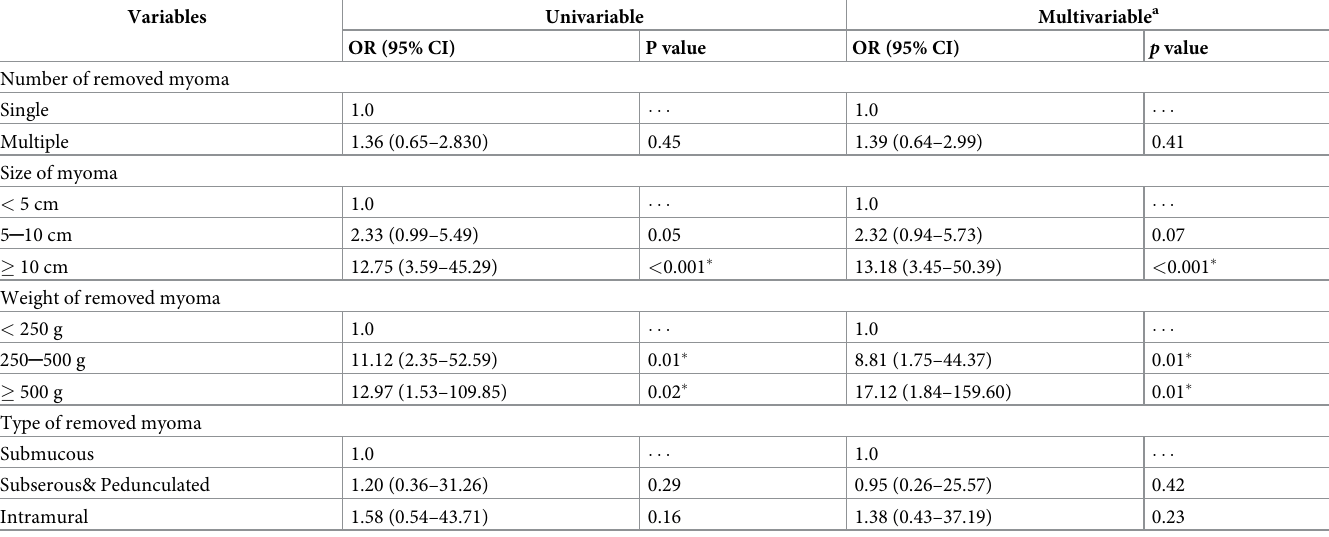
Table 8. Multivariate logistic regression model showing the unadjusted and adjusted odds ratios of association between various factors and transfusion in CM group (n =